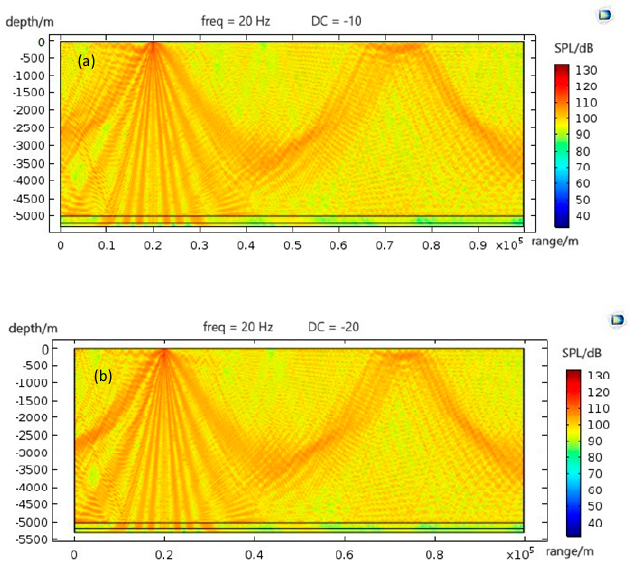
Figure 8. The distribution of sound pressure level under different intensities of cold vortex, ( a ) DC = − 10 m/s and ( b ) DC = − 20 m/s.